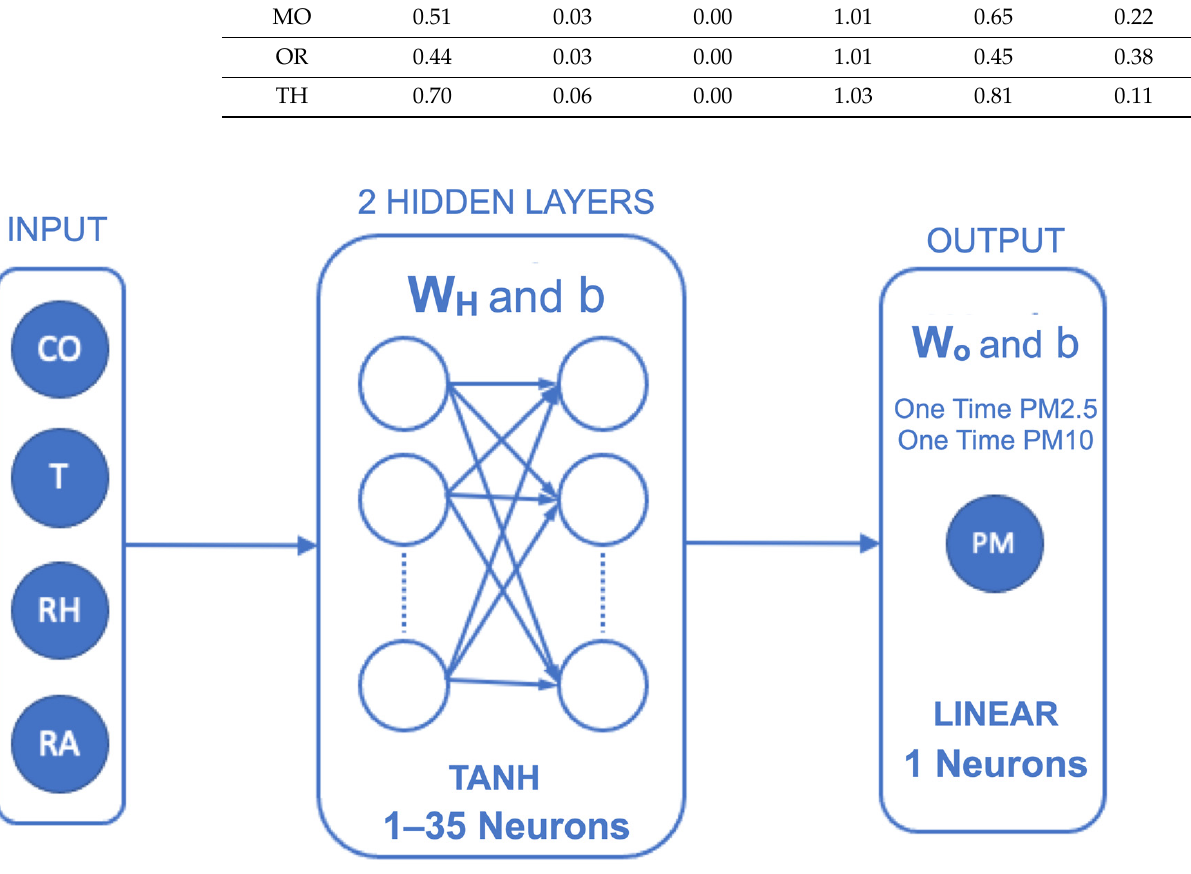
Figure 11. Schematic illustration of the feedforward neural networks (FFNs) employed in this